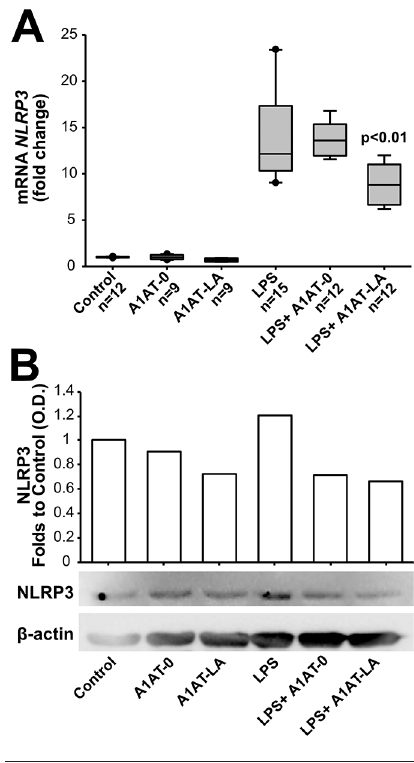
Figure 4. Effects of A1AT-0 and A1AT-LA on LPS-induced NLRP3 expression.